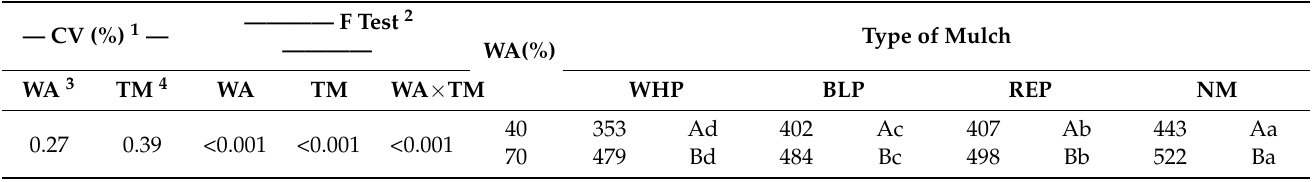
Table 3. Accumulated values of net irrigation depth (mm) as a function of wet area and